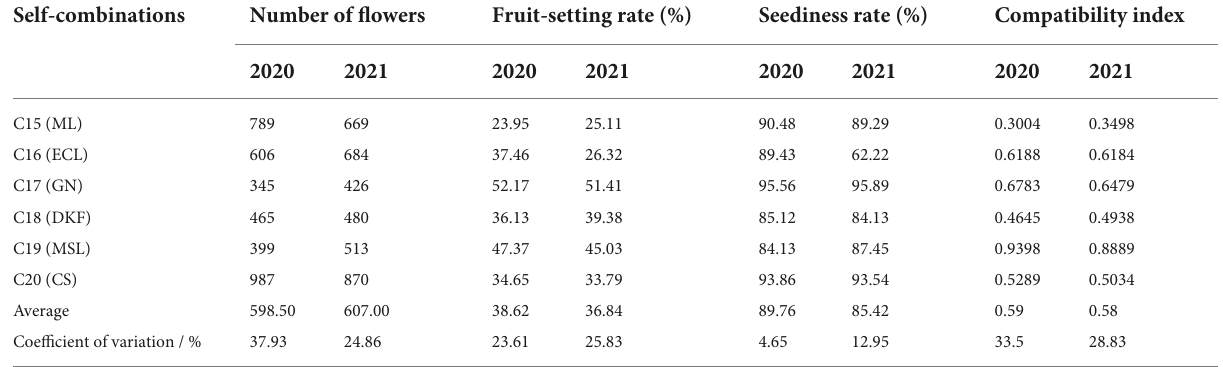
TABLE 2 Germination rate, emergence rate and seedling rate of self-inbred seeds. Self-combinations Number of flowers